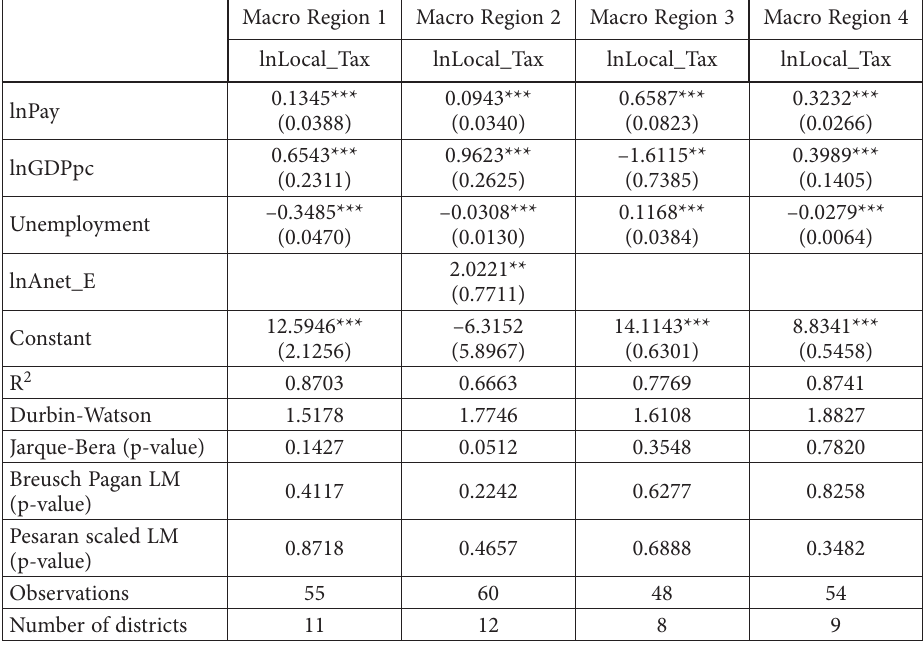
Table 5. Results of the panel regression